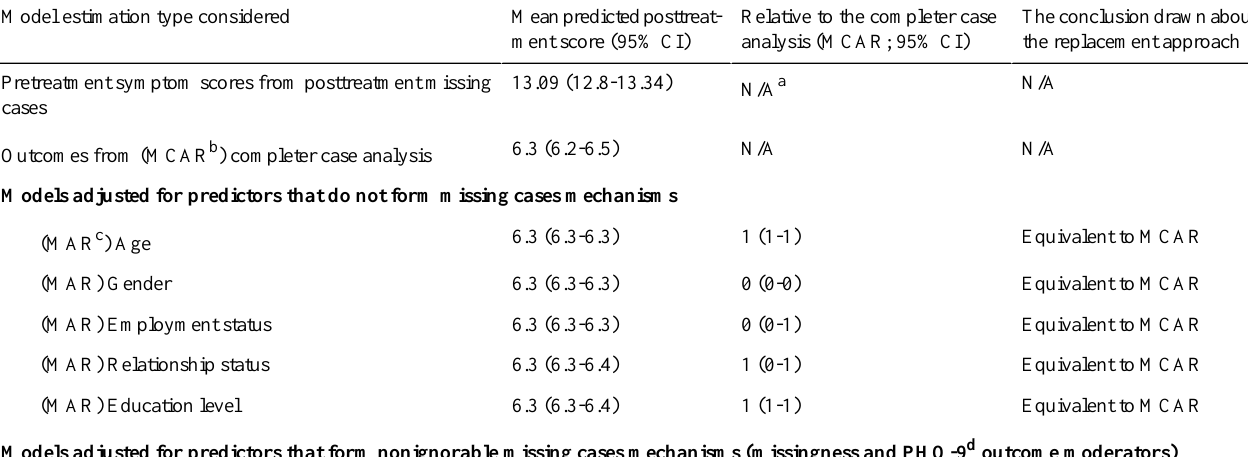
Table 8. Predicted Patient Health Questionnaire-9 outcomes generated with different replacement models—compared with average posttreatment model estimate (missing completely at random).